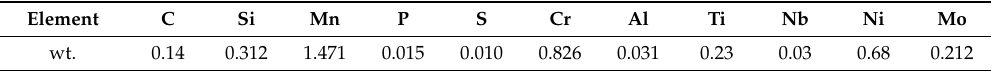
Table 1. The chemical constitution of Q690D steel (%, balance Fe).